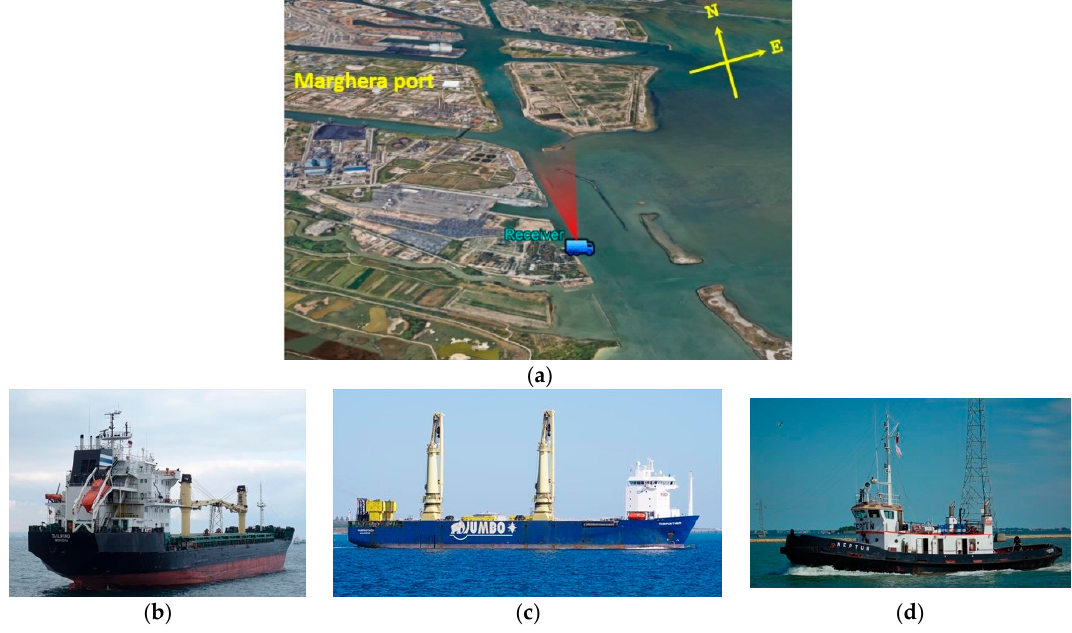
Figure 6. Marghera Port: ( a ) acquisition geometry; ( b ) Tailwind (cargo); ( c ) Fairpartner (heavy load carrier); and ( d ) Neptun (tug). Table 2. Marghera port—experimental and signal processing parameters.